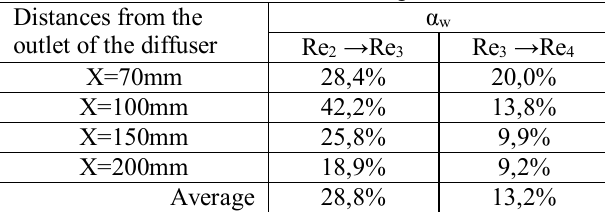
Tab. 2 Relative difference of velocity vector value distributions for diffuser with vanes at an angle of